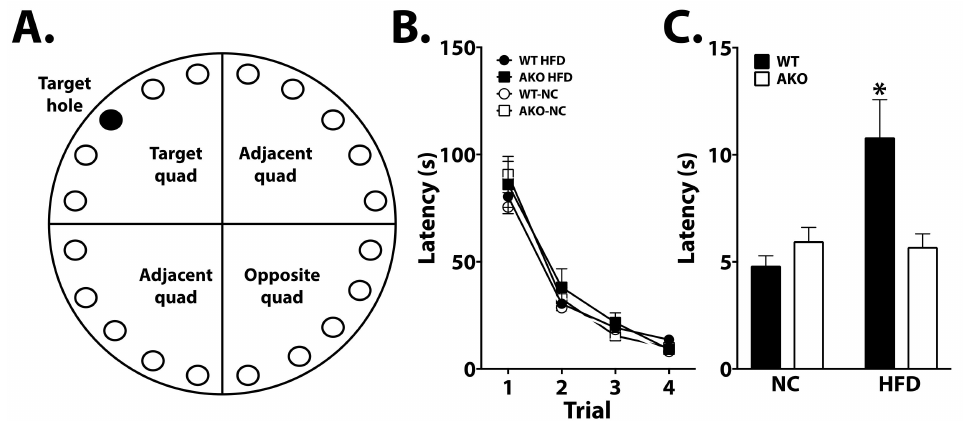
Figure 3. Loss of FABP4 is protective against HFD-induced cognitive decline. ( A ) Representation of Barnes maze apparatus. Training occurred over 4 consecutive days where mice learned to identify the target hole containing an escape box. ( B ) Performance was analyzed for latency to target hole over training days. Performance improved significantly in all groups over duration of training ( p < 0.0001). ( C ) During the probe (day 5), the escape hole was removed, and latency to target hole was analyzed. HFD-fed WT mice exhibited increased latency to target hole during this test ( p < 0.05 vs. WT-NC, AKO-NC, AKO-HFD). Data analyzed via one-way ANOVA and Tukey’s post-test. * p < 0.05.